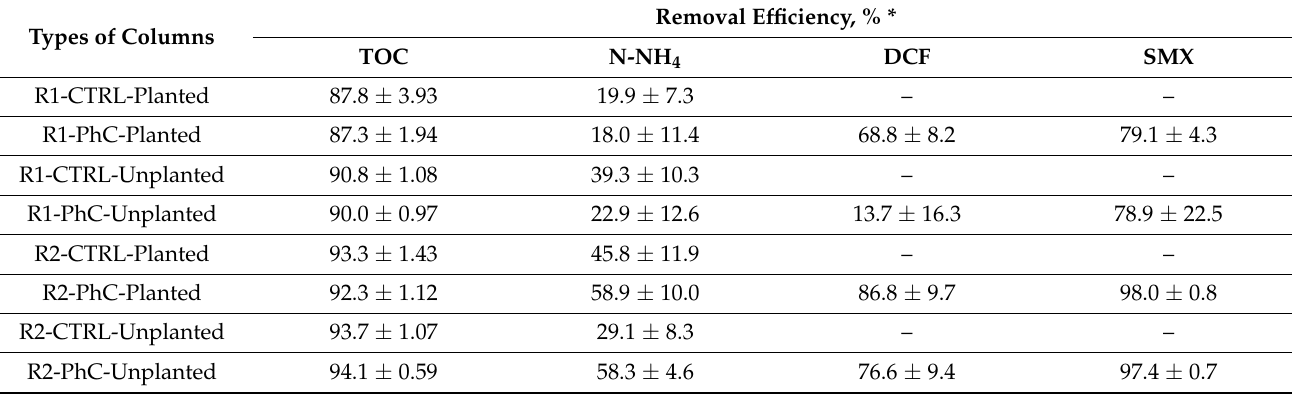
Table 3. Removal efficiency of TOC, N-NH 4 , DCF and SMX in